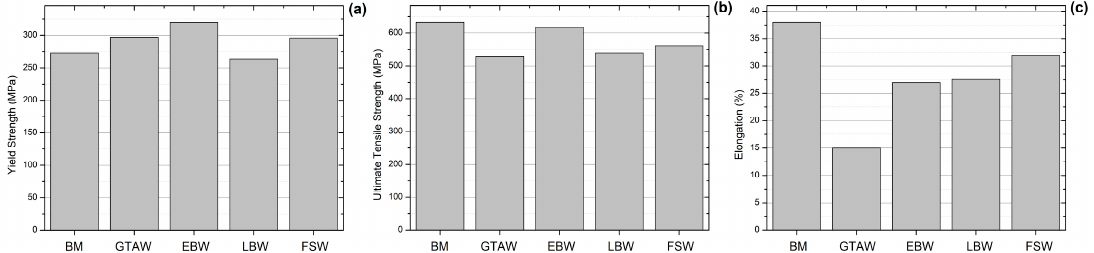
Figure 7. Comparison of mechanical properties of CoCrFeMnNi HEAs welded by different techniques ( a ) yield strength, ( b ) ultimate tensile strength, and ( c ) elongation.